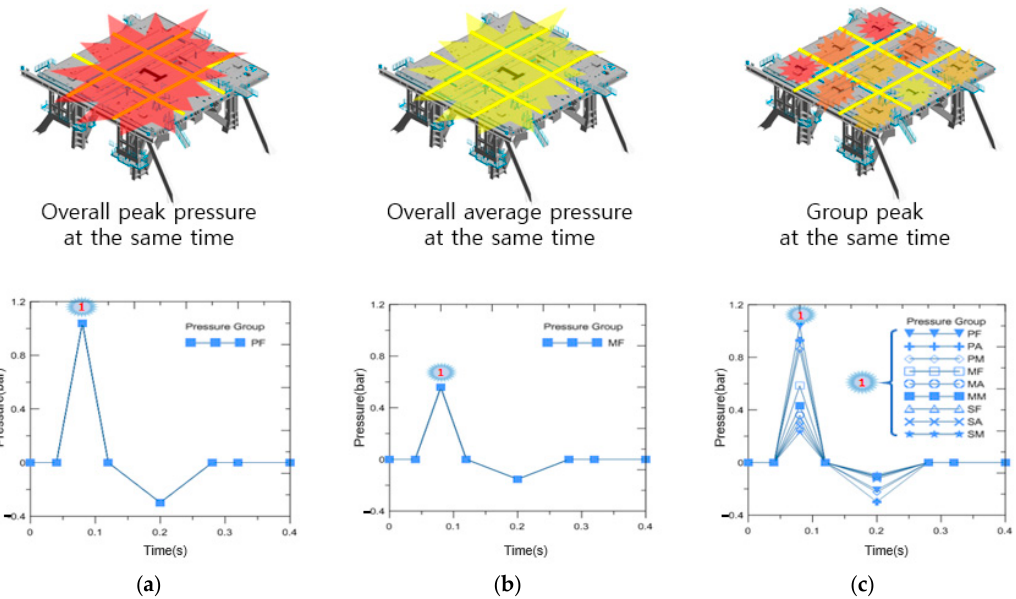
Figure 14. Blast pressure application and pressure configuration in time domain for ( a ) overall peak, ( b ) overall average, and ( c ) group peak.